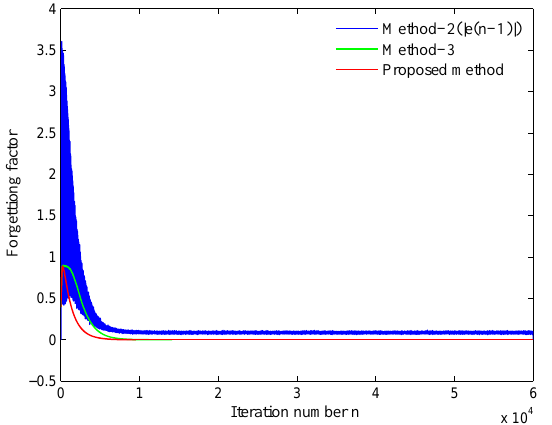
Figure 8. Mean variable forgetting factor of the proposed method for the fixed acoustic path S ( z ) shown in Figure